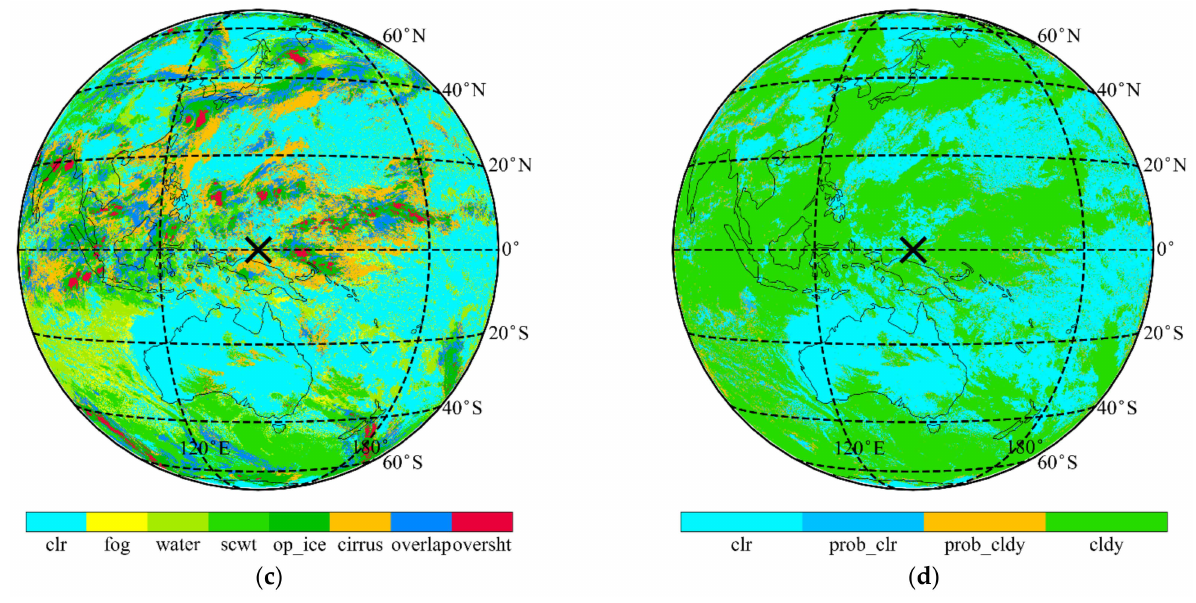
Figure 1. ( a ) Brightness temperature observations of AHI channel 13 (10.45 µ m), the white box indicates the data analysis region; ( b ) albedo observations of AHI visible channel 3 (0.65 µ m); ( c ) AHI- derived cloud types, including clear (clr, cyan), fog (yellow), water (light green), supercooled water (scwt, green), opaque ice (op_ice, forest green), cirrus (orange), overlapping (overlap, blue), and overshooting (oversht, red); and ( d ) AHI-derived clear (clr), probably clear (prob_clr), probably cloudy (prob_cldy), and cloudy (cldy) pixels at 0000 UTC 13 September 2021. Black cross indicates the sub-satellite